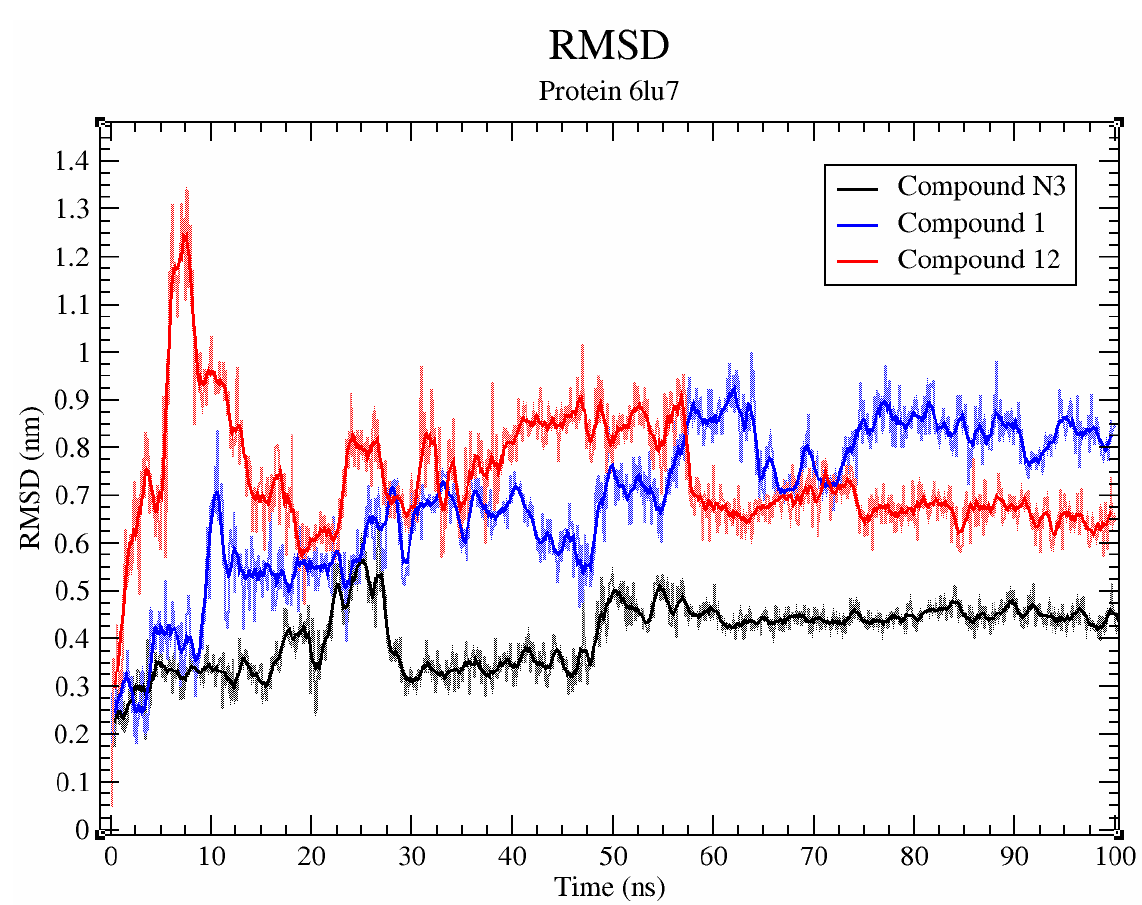
Figure 8. RMSD plot of compounds 1 , 12 and co-crystallized ligand (N3) during a 100 ns MD simulation with SARS-CoV-2 3CL protease.